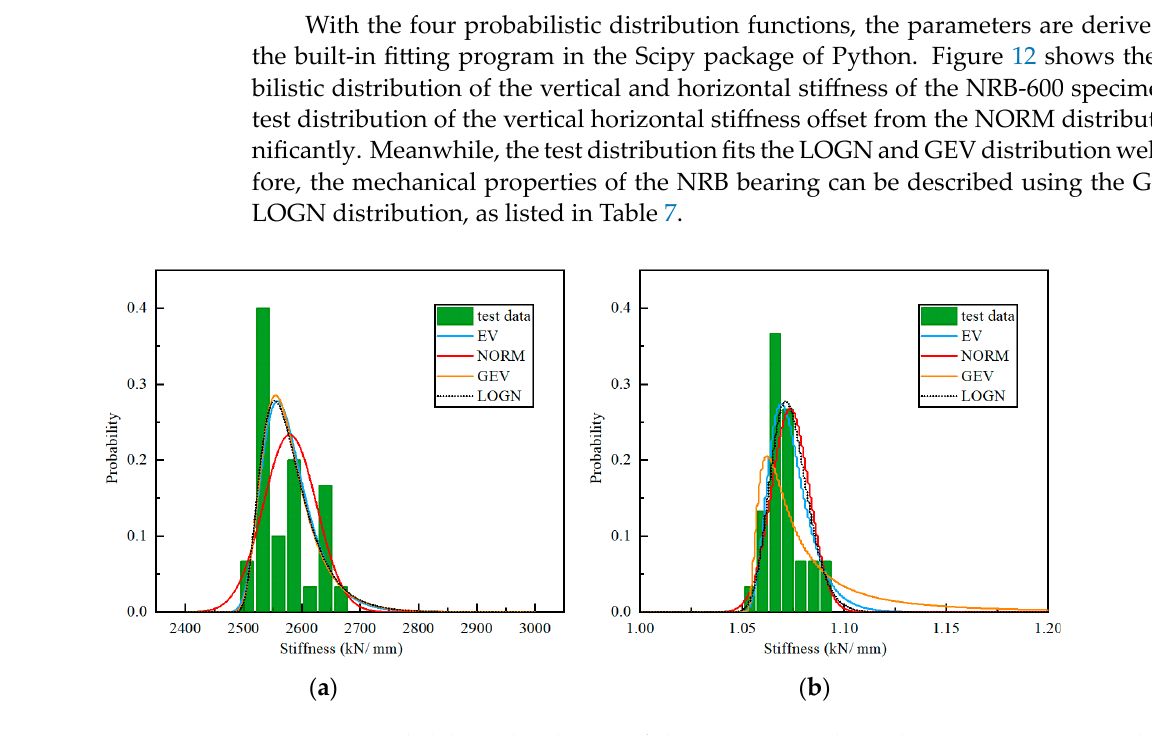
Figure 12. Probabilistic distribution of the NRB ‐ 600 mechanical properties: ( a ) vertical stiffness; ( b ) horizontal stiffness. Table 7. Statistic and p ‐ value in the Kolmogorov ‐ Smirnov test of the NRB specimen.